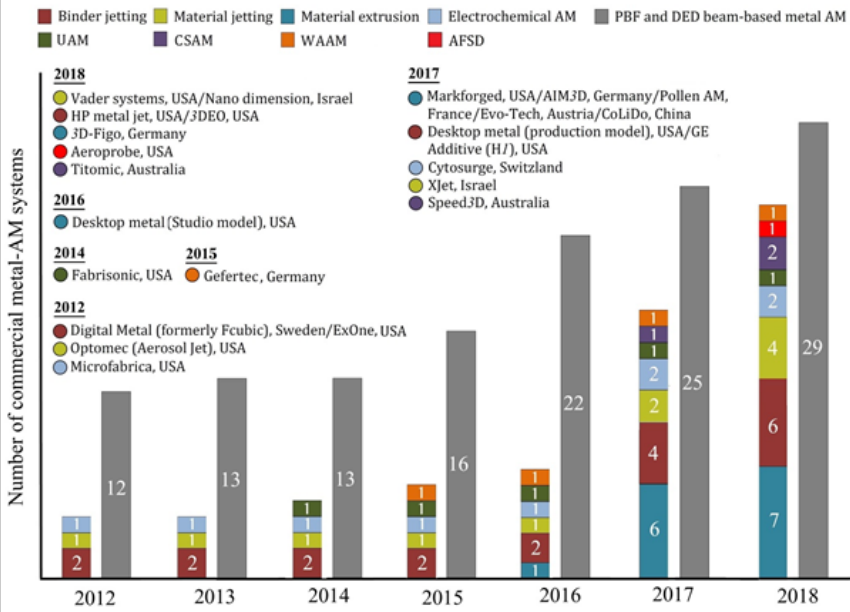
Figure 1. Classification of the main current metal AM processes, including beam-based and beamless techniques.